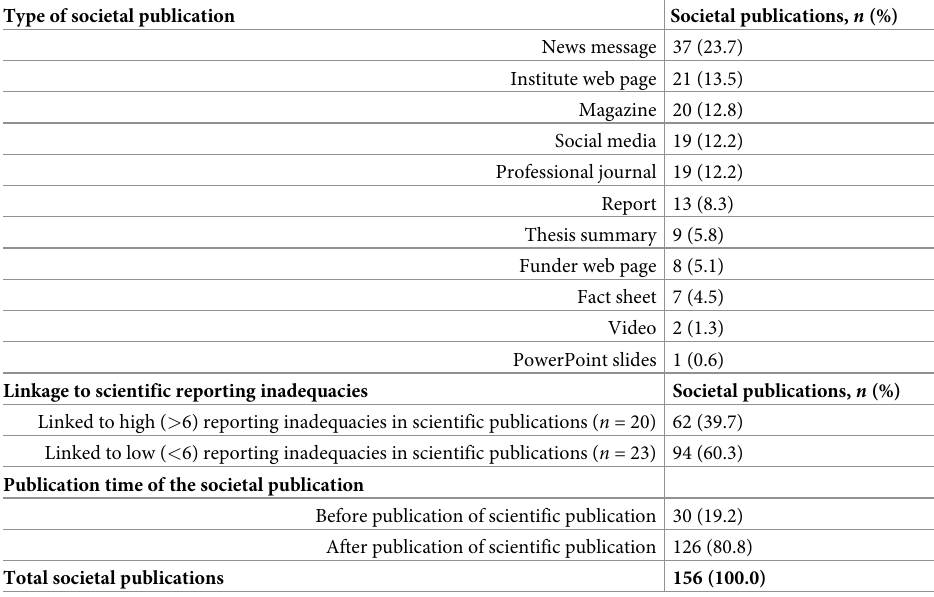
Table 1. Characteristics of the analysed societal